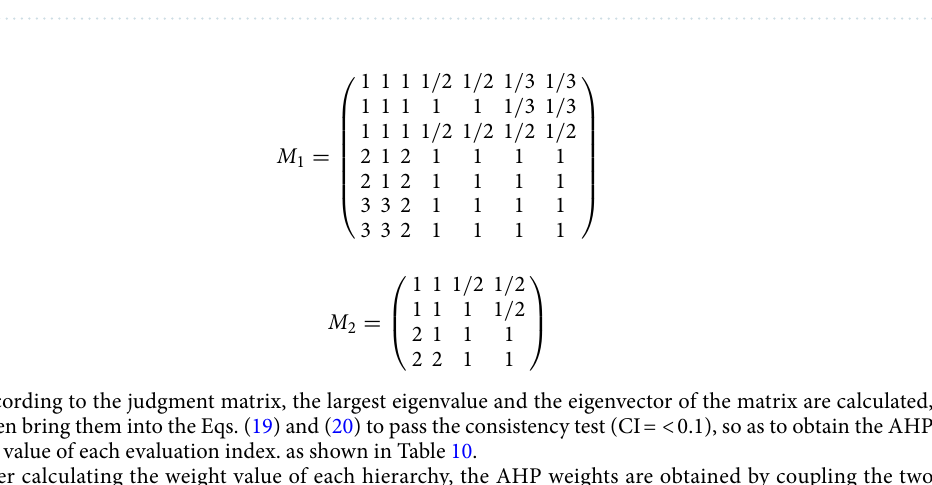
Figure 5. Correlation analysis between various influencing